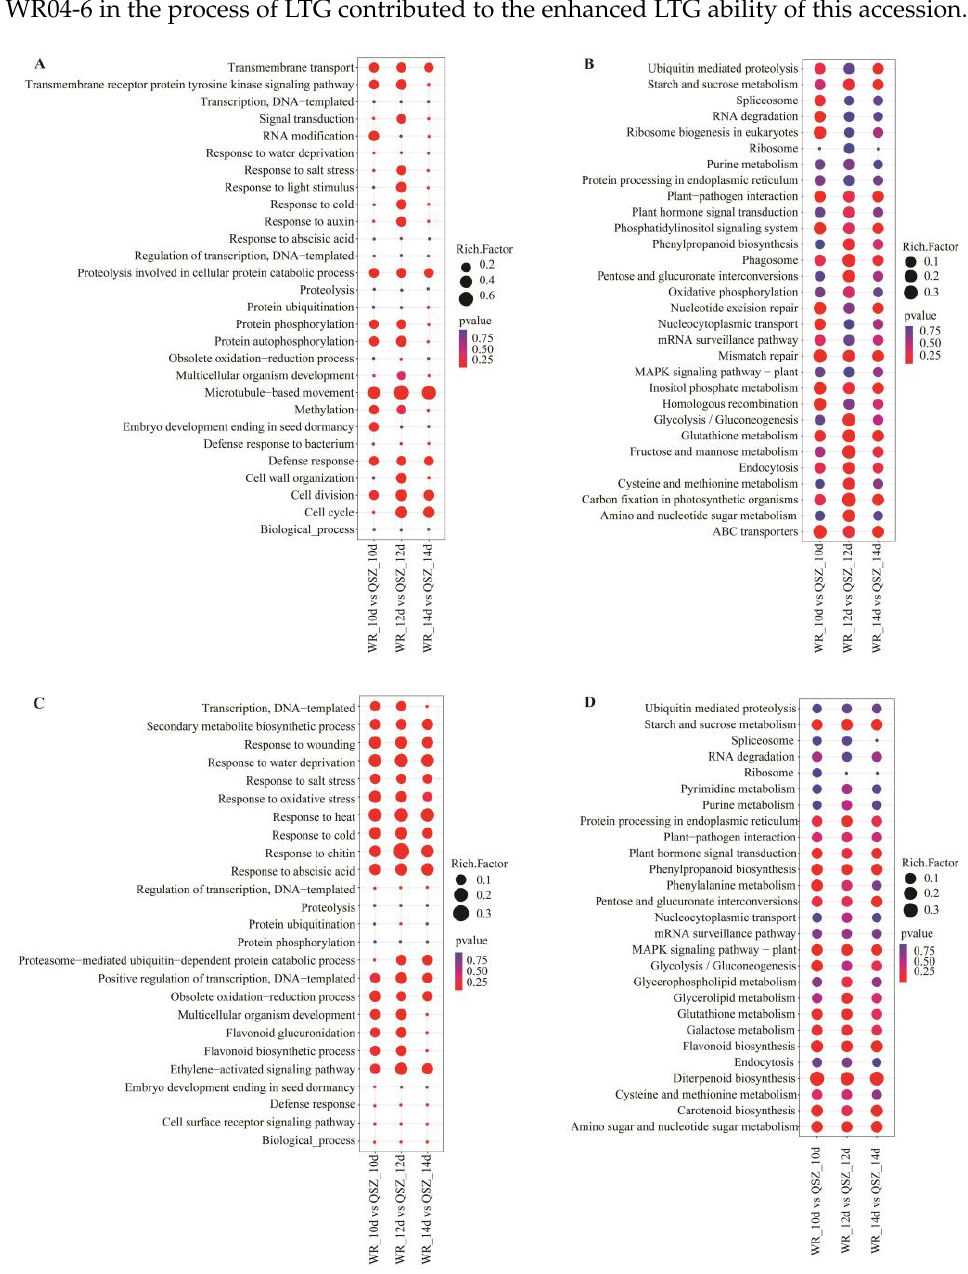
Figure 3. Enrichment analysis of DEGs between WR04-6 and QSZ at 10 °C. ( A ) Top 20 enriched GO-BP terms of the up-regulated DEGs ( p ≤ 0.05). ( B ) Top 20 enriched KEGG pathways of the up-regulated DEGs ( p ≤ 0.05). ( C ) Top 20 enriched GO-BP terms of the down-regulated DEGs ( p ≤ 0.05). ( D ) Top 20 enriched KEGG pathways of the down-regulated DEGs ( p ≤ 0.05).